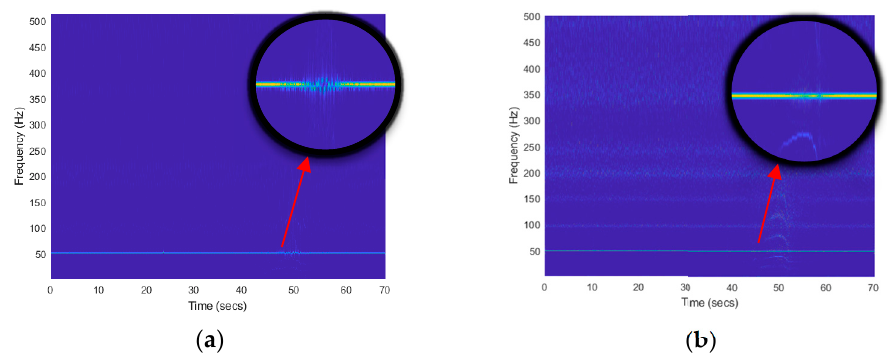
Figure 8. Comparison of SSWT of mother wavelet “Morlet” and “Bump” where ( a ) is the “Morlet” mother wavelet and ( b ) is the “Bump” mother wavelet.